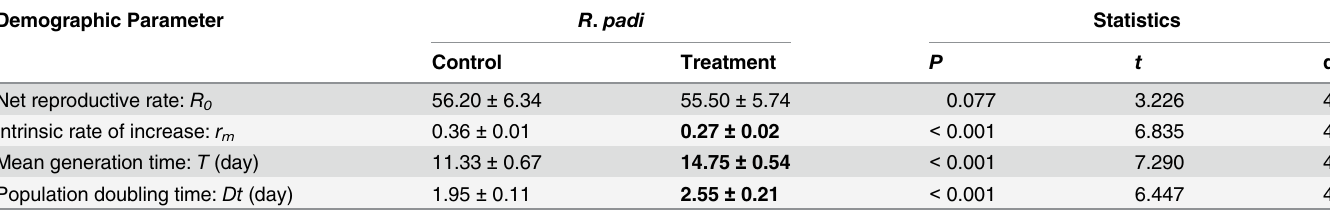
Table 4. Effect of LC 25 of pirimicarb on demographic parameters of R . padi .